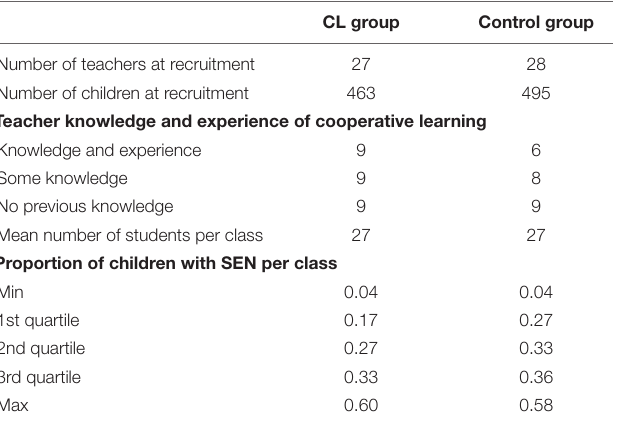
TABLE 1 | Background characteristics of classes and teachers in intervention and control groups. CL group Control